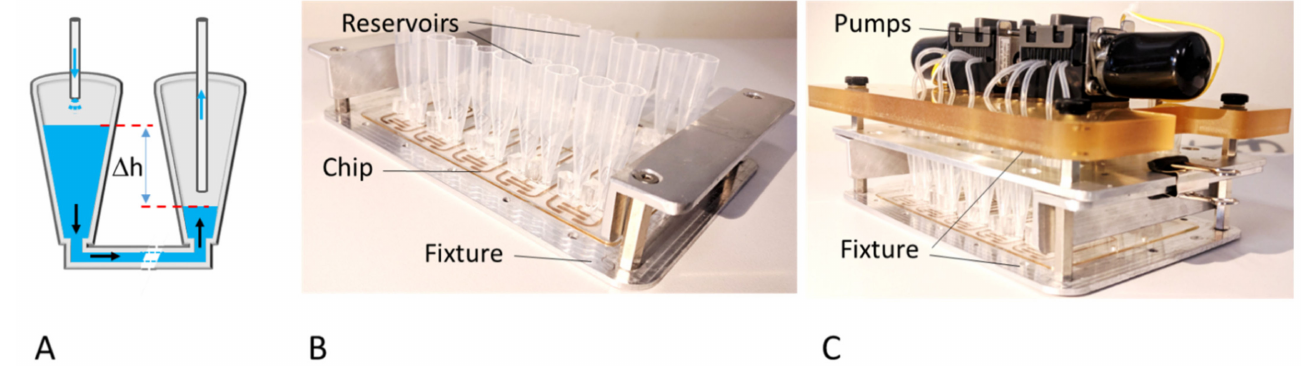
Figure 2. Parallelized perfusion setup: ( A ) Scheme of gravitation-driven flow. Medium reservoirs (V ≈ 1 mL) were placed on the channel inlet and outlet. Tubes reaching into the reservoirs in connection with micro-peristaltic pumps that operated intermittently were used to move perfused medium from the outlet reservoir back to the inlet reservoir, thus maintaining the level difference, ∆ h, driving unidirectional medium flow. ( B ) Chip in fixture with medium reservoirs attached on fluid ports of MFC. ( C ) Perfusion setup with 10 channel microfluidic pumps mounted on top of the chip fixture to yield an easy-to-use and incubator compatible perfusion